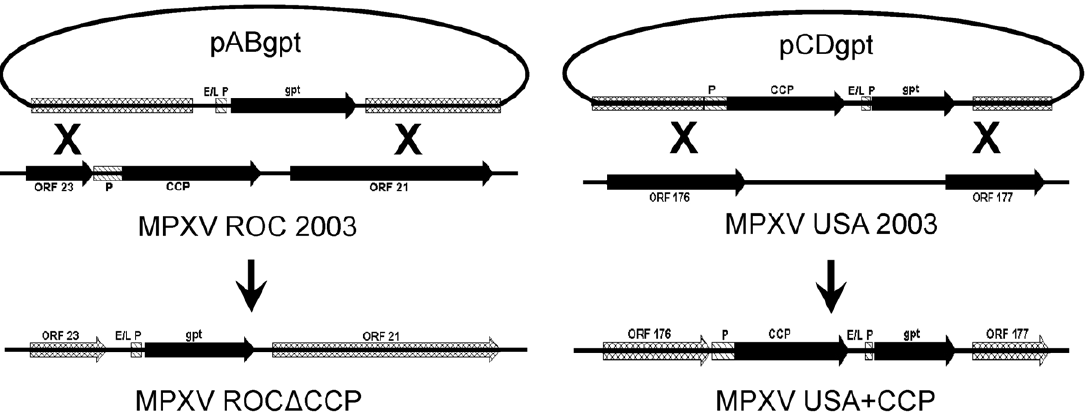
Figure 1. Constructs used for recombinant virus formation. Plasmid maps of pABgpt and pCDgpt illustrate the recombination sites within ROC 2003 and USA 2003 genomes. For both recombinant strains, gpt expression was controlled by a synthetic early-late promoter sequence. In the recombinant USA + CCP, the ccp gene was under its own native promoter from ROC 2003, and the insert was located in the non-coding region between open reading frames 177 and 176 of USA 2003.